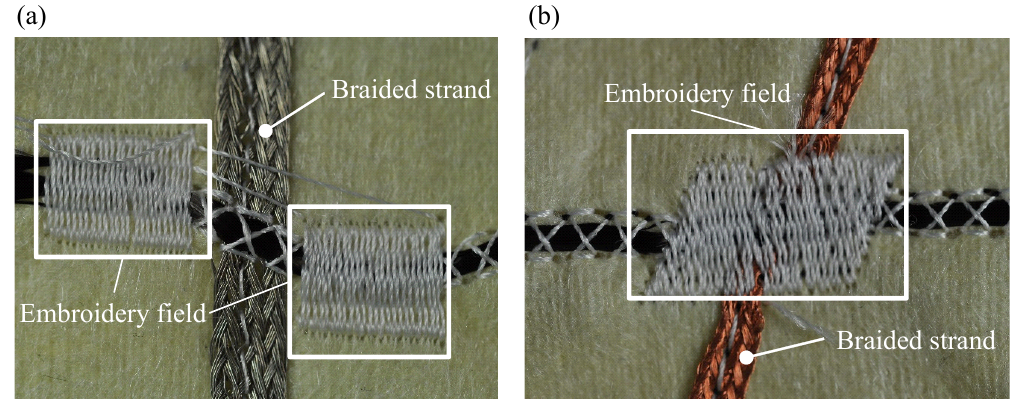
Figure 10. ( a ) Lateral positioning of the embroidery fields; and ( b ) central positioning of the embroidery field above the contact